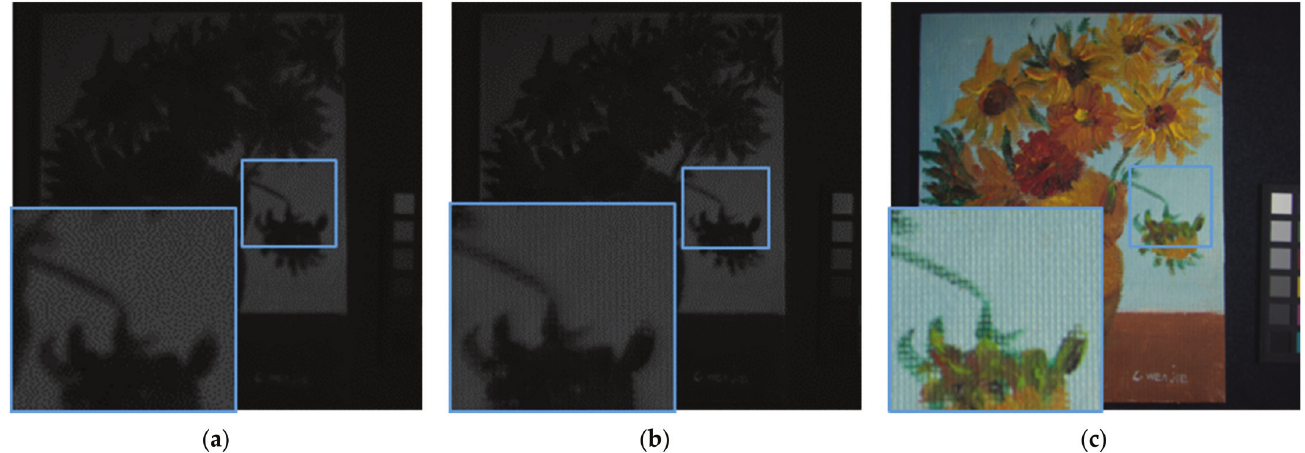
Figure 12. Enhancement from ground truth. ( a ) 1st band of ground truth; ( b ) 1st band of ours; ( c ) original RGB